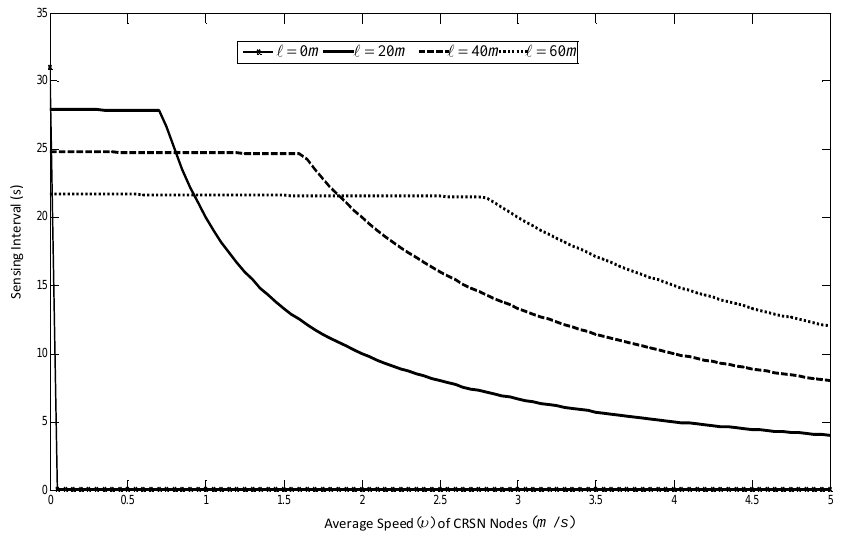
Figure 11. Effect of speed on spectrum sensing intervals in a cognitive radio sensor network